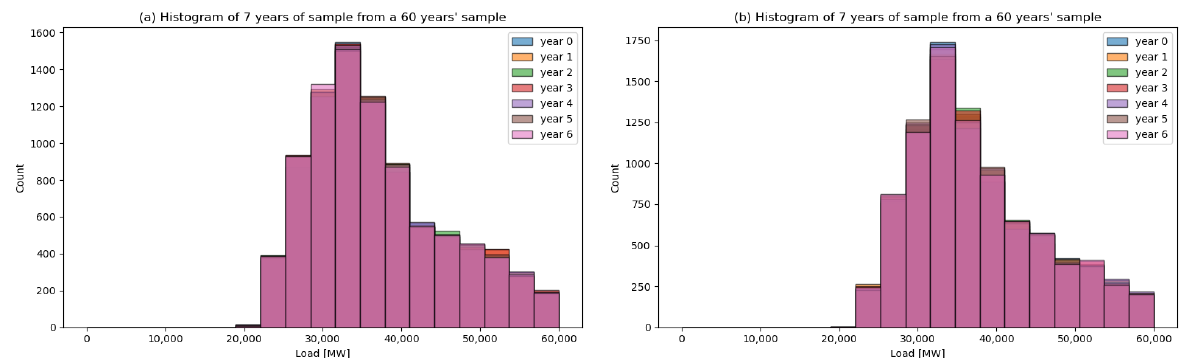
Figure 11. ( a ) Histogram of synthetic load samples trained from 2012; ( b ) Histogram of synthetic load samples trained from